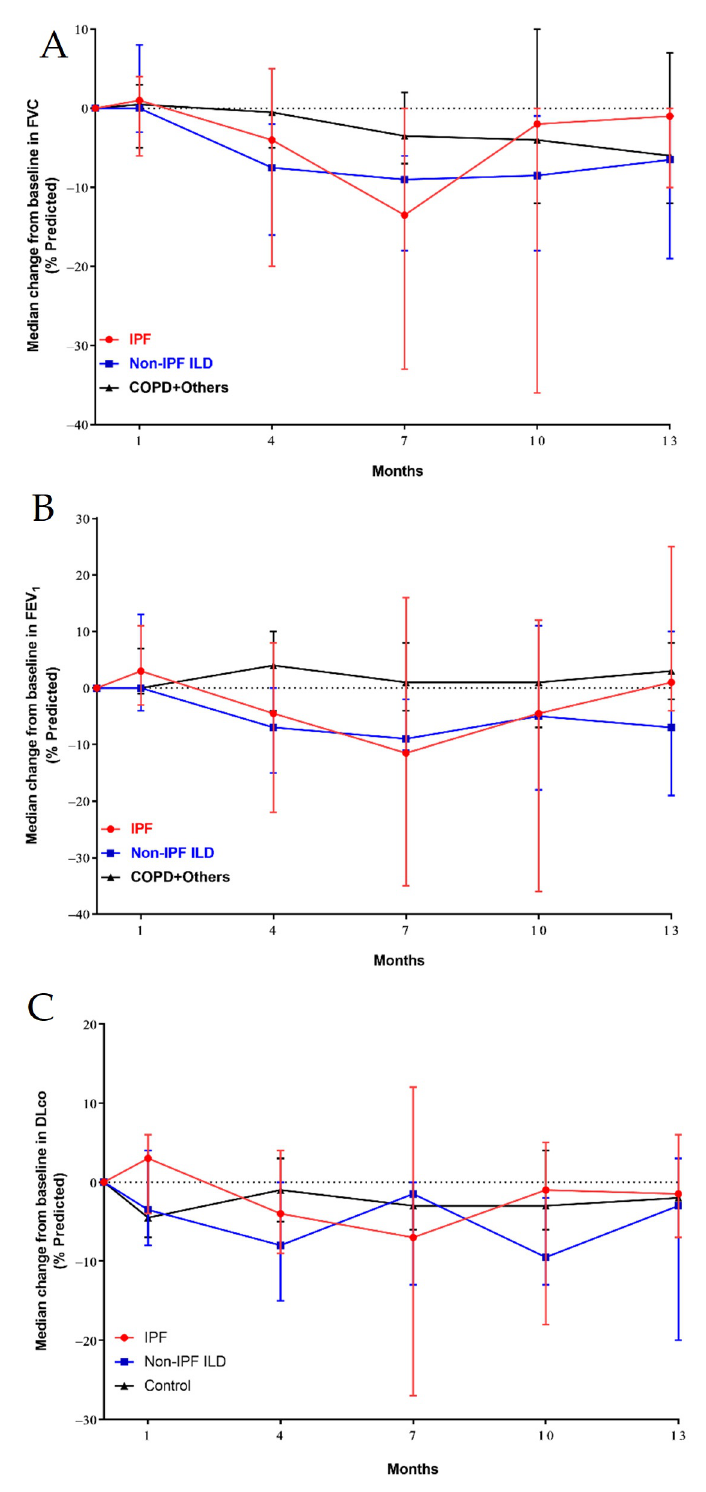
Figure 1. Mean observed changes in ( A ) forced vital capacity, ( B ) forced expiratory volume in 1 s, and ( C ) diffusing capacity of the lungs for carbon monoxide in lung cancer patients with poor lung function. Bars indicate standard